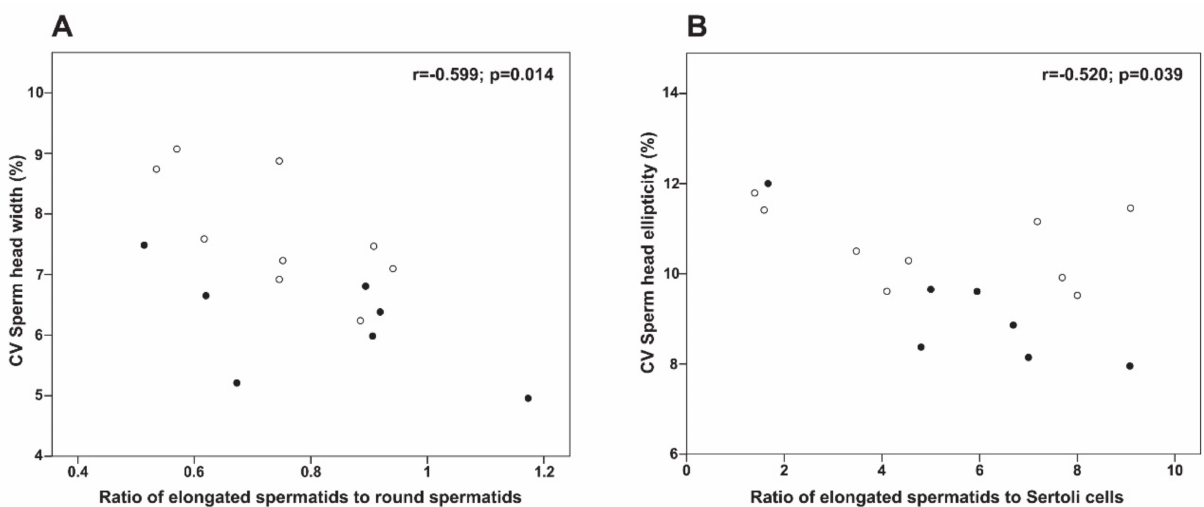
Figure 4. Relationships between intra-male coefficient of variation (CV) in sperm head size and spermatogenic function in sexually mature tomcats. Relationships between ( A ) CV of sperm head width and ratio of elongated spermatids to round spermatids (ES/RS; index of post-meiotic germ cell loss) and ( B ) CV of sperm head ellipticity and ratio of elongated spermatids to Sertoli cells (ES/SC; index of Sertoli cell functionality). White dots indicate <1-year-old sexually mature tomcats, while black dots indicate >1-year-old sexually mature